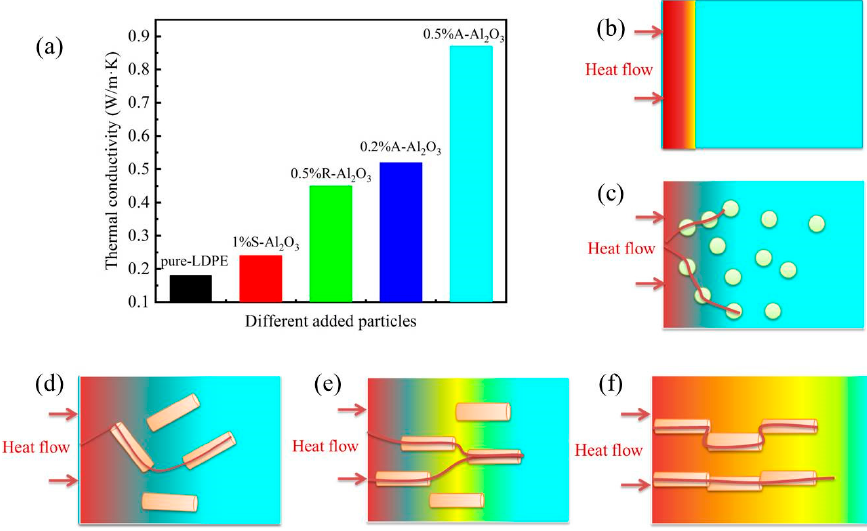
Figure 9. The thermal conductivity of Al 2 O 3 /LDPE with different particles and the heat flow ( a ) the diagram of heat flow ( b ) pure LDPE, ( c ) S- Al 2 O 3 /LDPE ( d )R-Al 2 O 3 /LDPE ( e ) 0.1%A-Al2O3/LDPE ( f ) 0.1%A-Al2O3/LDPE composite.